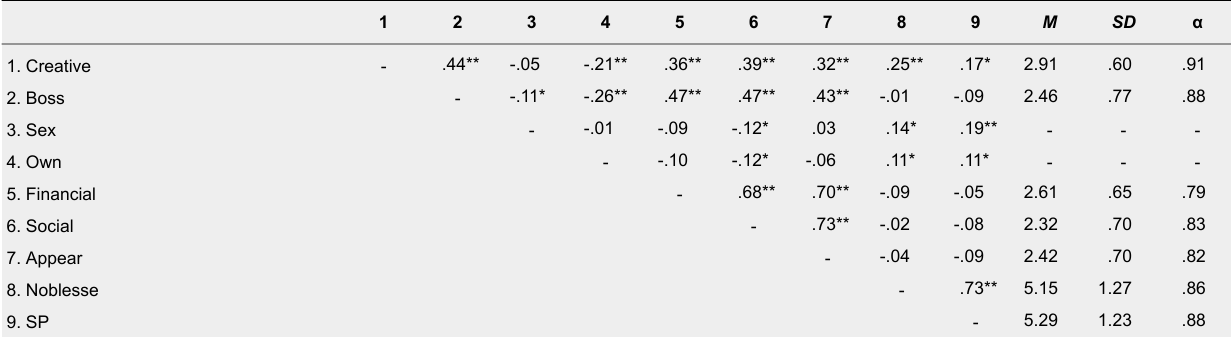
Bivariate Correlations, Means, Standard Deviations, and Alphas for Scales and Subscales (Study 3, N = 502)